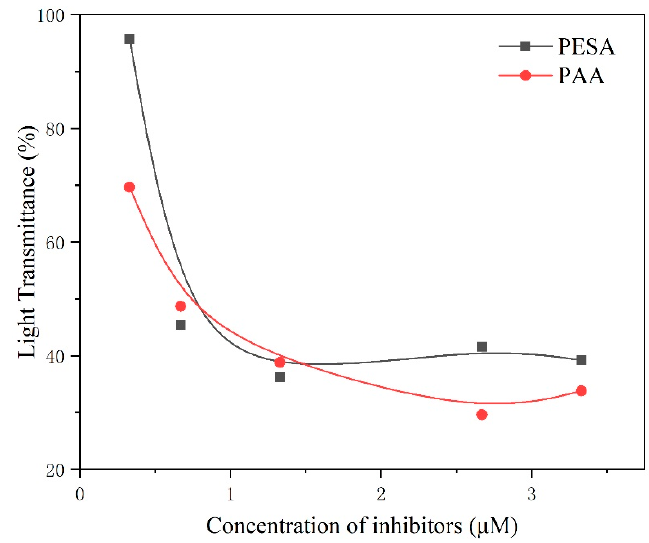
Figure 4. Effect of the PESA and PAA on the dispersion of ferric oxide at different concentrations.